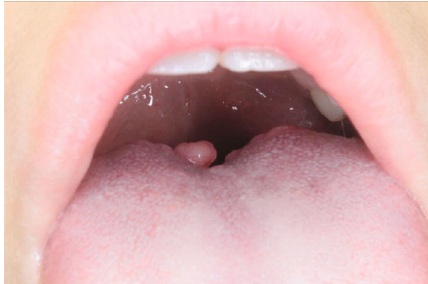
Figure 1: Intraoral clinical fi ndings of the 11-year-old female patient. A mass approx. 7 mm in dia. was observed on the posterior dorsum of the tongue. This lesion with no symptoms was diagnosed clinically as a fi broma.